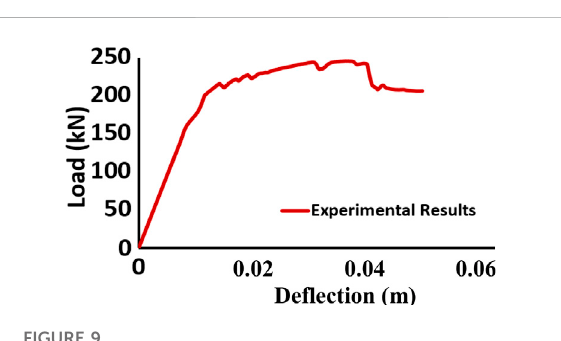
FIGURE 7 Crack-Time behaviour of RCB with 50% bottom ash.